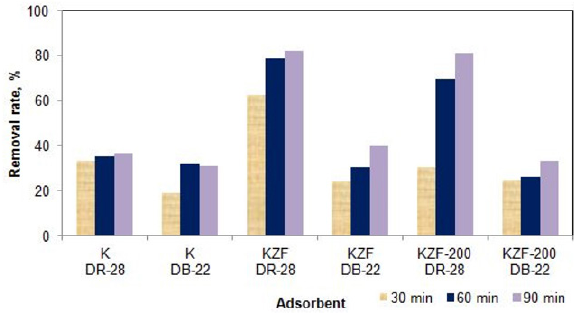
F ig. 5. Effect of the heat treatment on the removal of (a) DR-28 and (b) DB-22 (initial concentration: 30 mg/L, temperature: 21 °C, ad- sorbent amount: 0.6g/200mL, initial pH: original)